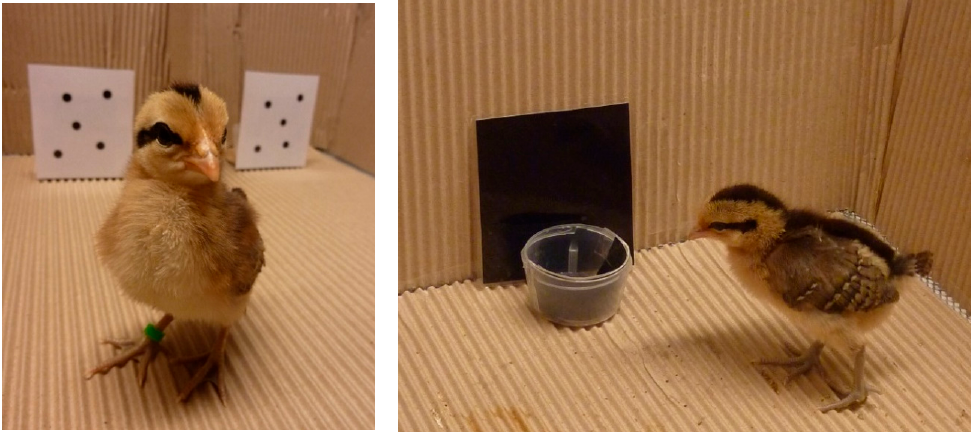
Figure 2. Red junglefowl chicks in behavioural assays measuring cognitive performance.